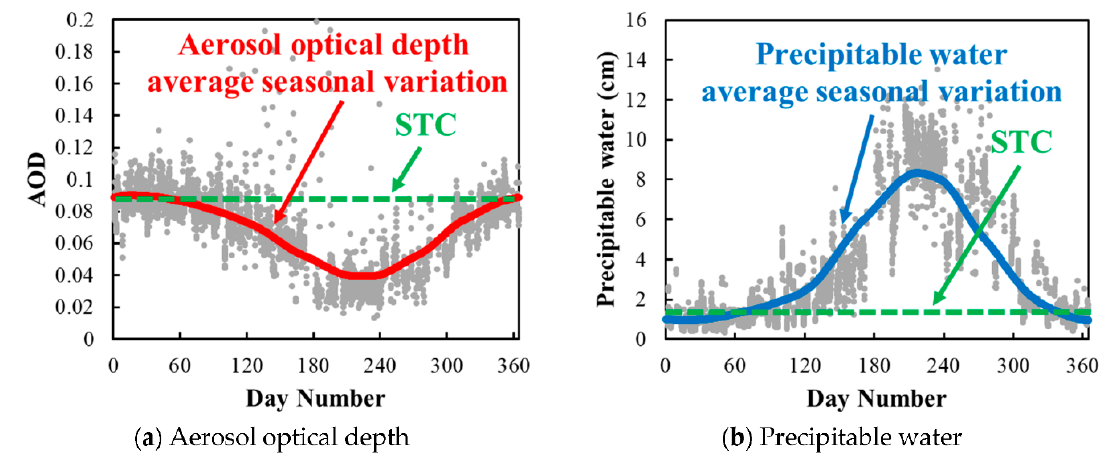
Figure 4. Seasonal trend of atmospheric parameters in Miyazaki [97]: ( a ) Seasonal trend of aerosol optical depth; ( b ) Seasonal trend of precipitable water.